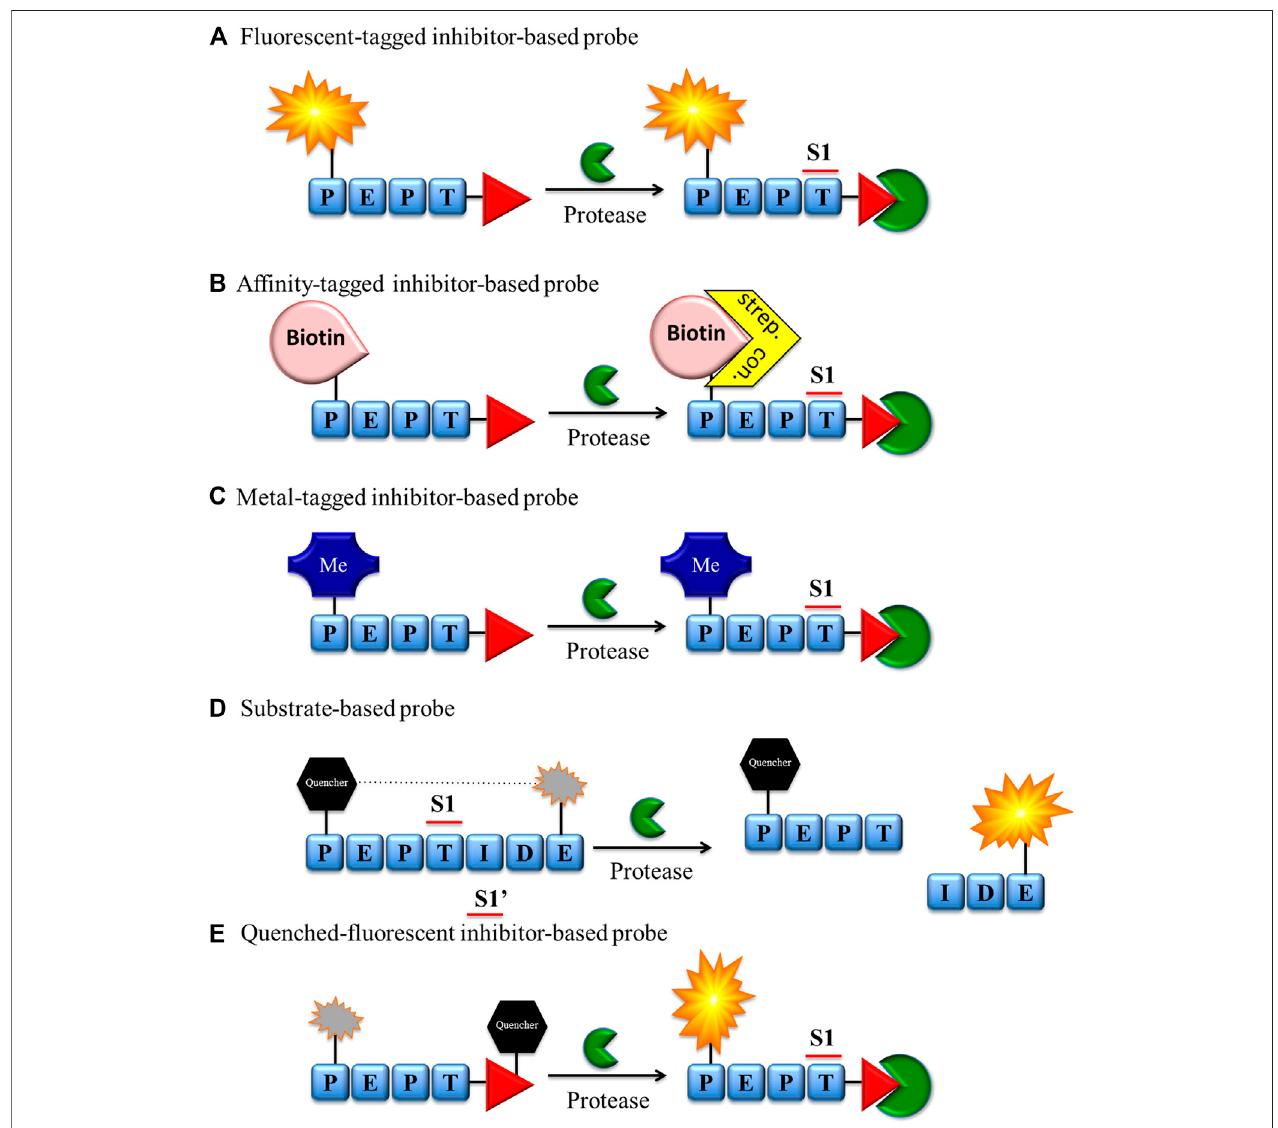
FIGURE 2 | Chemical reagents for imaging serine proteases. (A) Fluorescent, (B) biotin, (C) metal-tagged and (E) quenched- fl uorescent inhibitor-based bind covalently with the enzyme active site. The fl uorescent probe-enzyme reactions (A) , (D) , and (E) can be detected after excitation of the sample with a fl uorescence microscope or fl ow cytometry, while the biotin probe-enzyme complex (B) can be detected through biotin-binding protein (streptavidin or avidin) conjugated with a fl uorescent label. (C) Metal-tagged probe-enzyme complex is directly detected using special equipment (e.g., CyTOF).